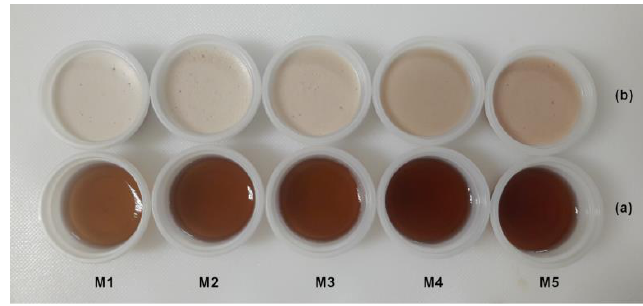
Figure 3. Color changes of gelatin gels: ( a ) CBJ–gelatin gels; ( b ) aerated CBJ–gelatin gels.